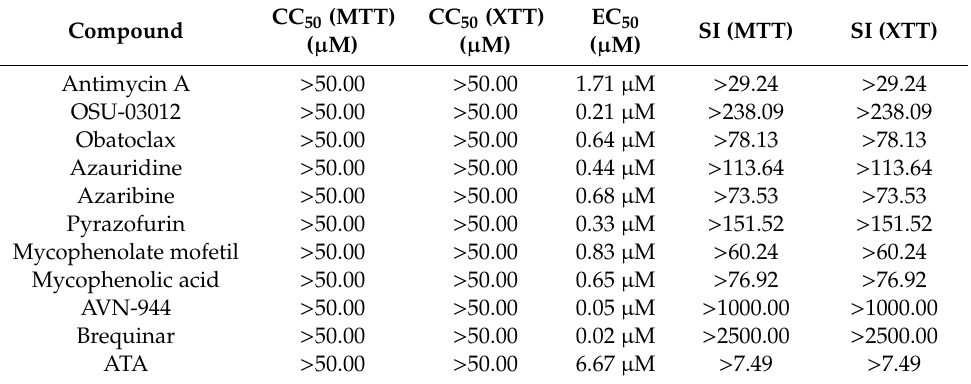
Table 6. CC 50 , EC 50 and SI of the compounds against ZIKV Paraiba / 2015 in A549